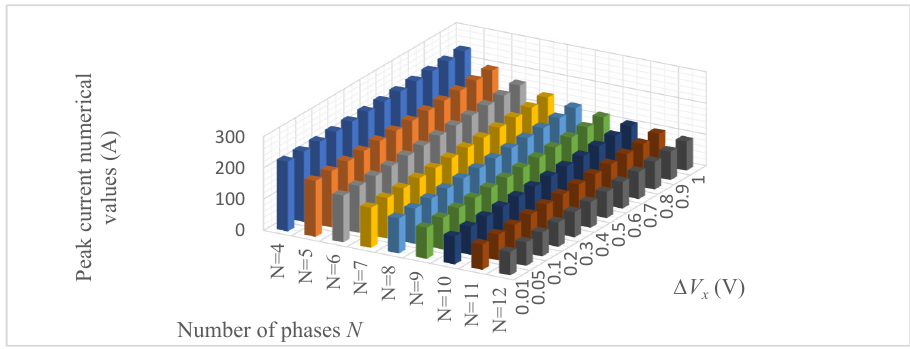
Figure 21. Peak currents of the SC circuit at different ∆ V x for different numbers of phases.